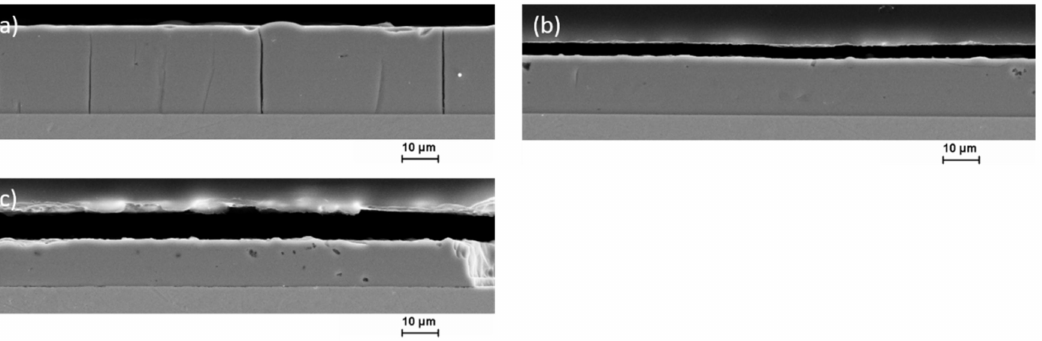
Figure 13. SEM micrographs of cross-sections of electrodeposited Fe-Cr-Ni coatings under stepped DC t on = 10 s, t off = 5 s conditions for three depositions: ( a ) first deposition (2 h of electrolyte use) with microcracks; ( b ) second deposition (4 h of electrolyte use) without any microcracks; and ( c ) third deposition (6 h of electrolyte use) with some material chipping.